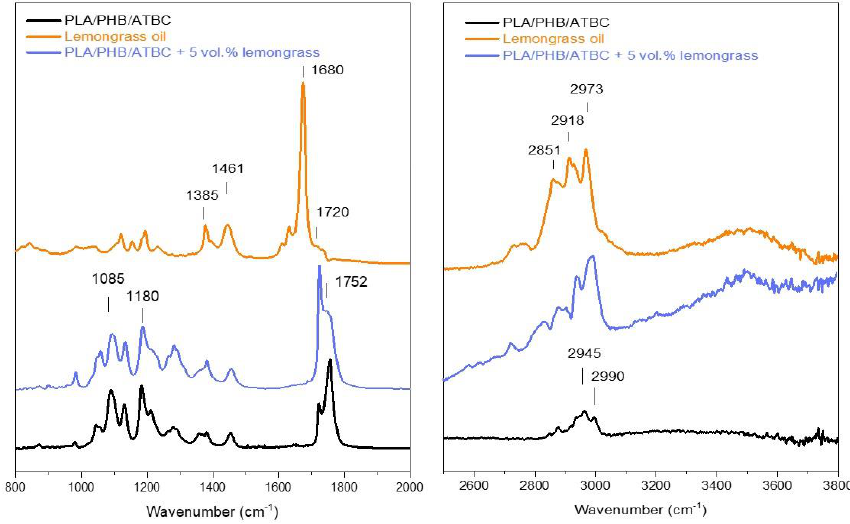
Figure 4. ATR-FTIR spectra of neat ( a ) PLA/PHB/ATBC, lemongrass EO, and ( b ) PLA/PHB/ATBC + 5% lemongrass EO nanofibrous composite.